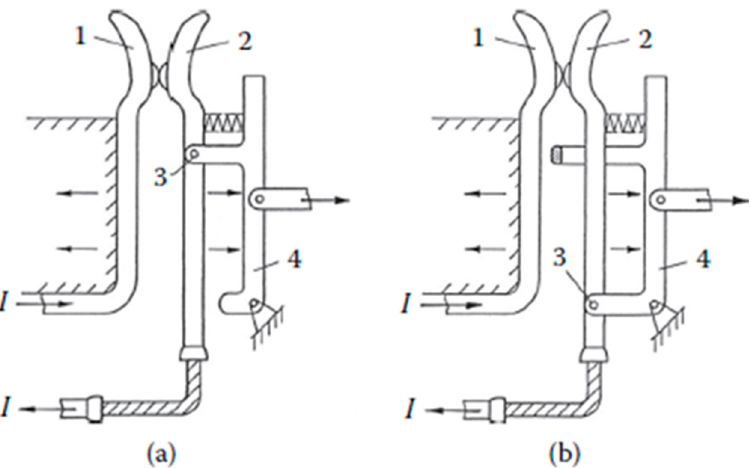
Figure 6. Dynamic intensification of: ( a ) contact force; ( b ) blow-out force. 1—fixed contact; 2—moving contact; 3—pivot point of moving contact; 4—switching lever [2].